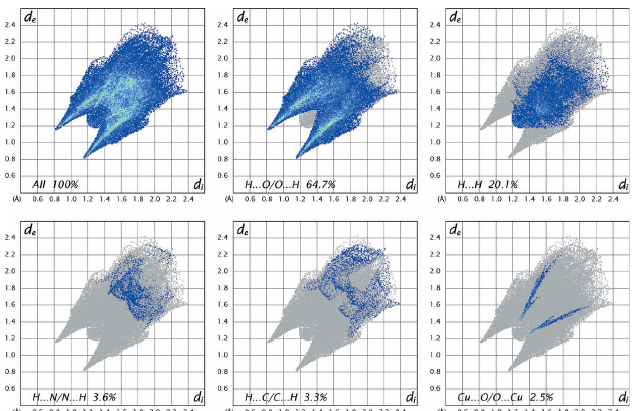
Table 2 play a key role in the molecular packing of the complex, and nearly two thirds (or 64.7%) of intermolecular interactions correspond to O (cid:2) (cid:2) (cid:2) H/H (cid:2) (cid:2) (cid:2) O contacts The overall two-dimensional fingerprint plot and those delineated into O (cid:2) (cid:2) (cid:2) H/H (cid:2) (cid:2) (cid:2) O, H (cid:2) (cid:2) (cid:2) H, N (cid:2) (cid:2) (cid:2) H/H (cid:2) (cid:2) (cid:2) N, C (cid:2) (cid:2) (cid:2) H/H (cid:2) (cid:2) (cid:2) C and